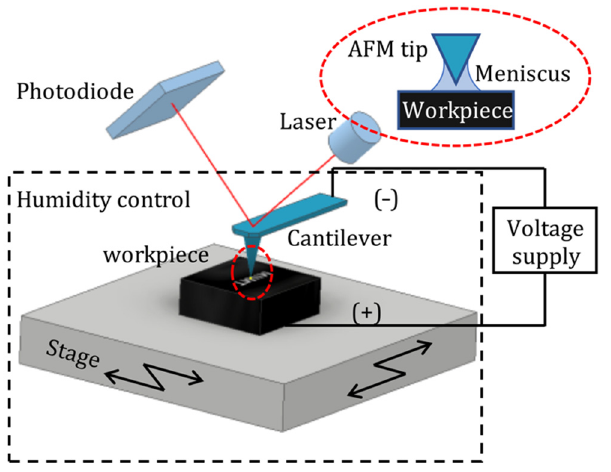
Figure 1. Schematic diagram of AFM-based electrochemical etching apparatus with a relative humidity control environment.